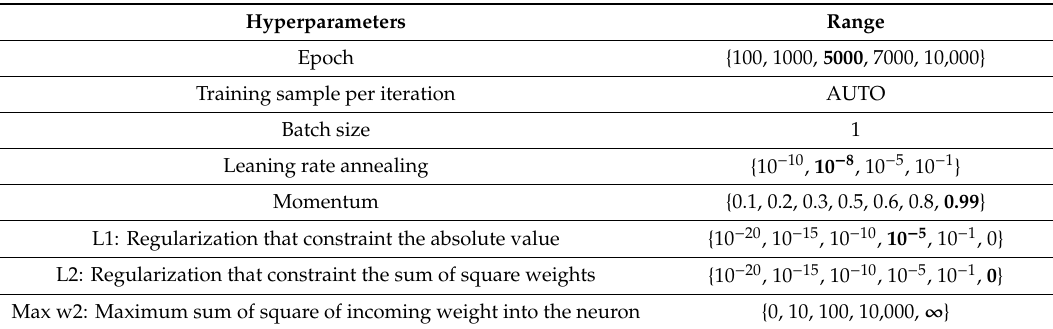
Table 2. Hyperparameters values evaluated in the proposed Deep Neural Network (DNN)